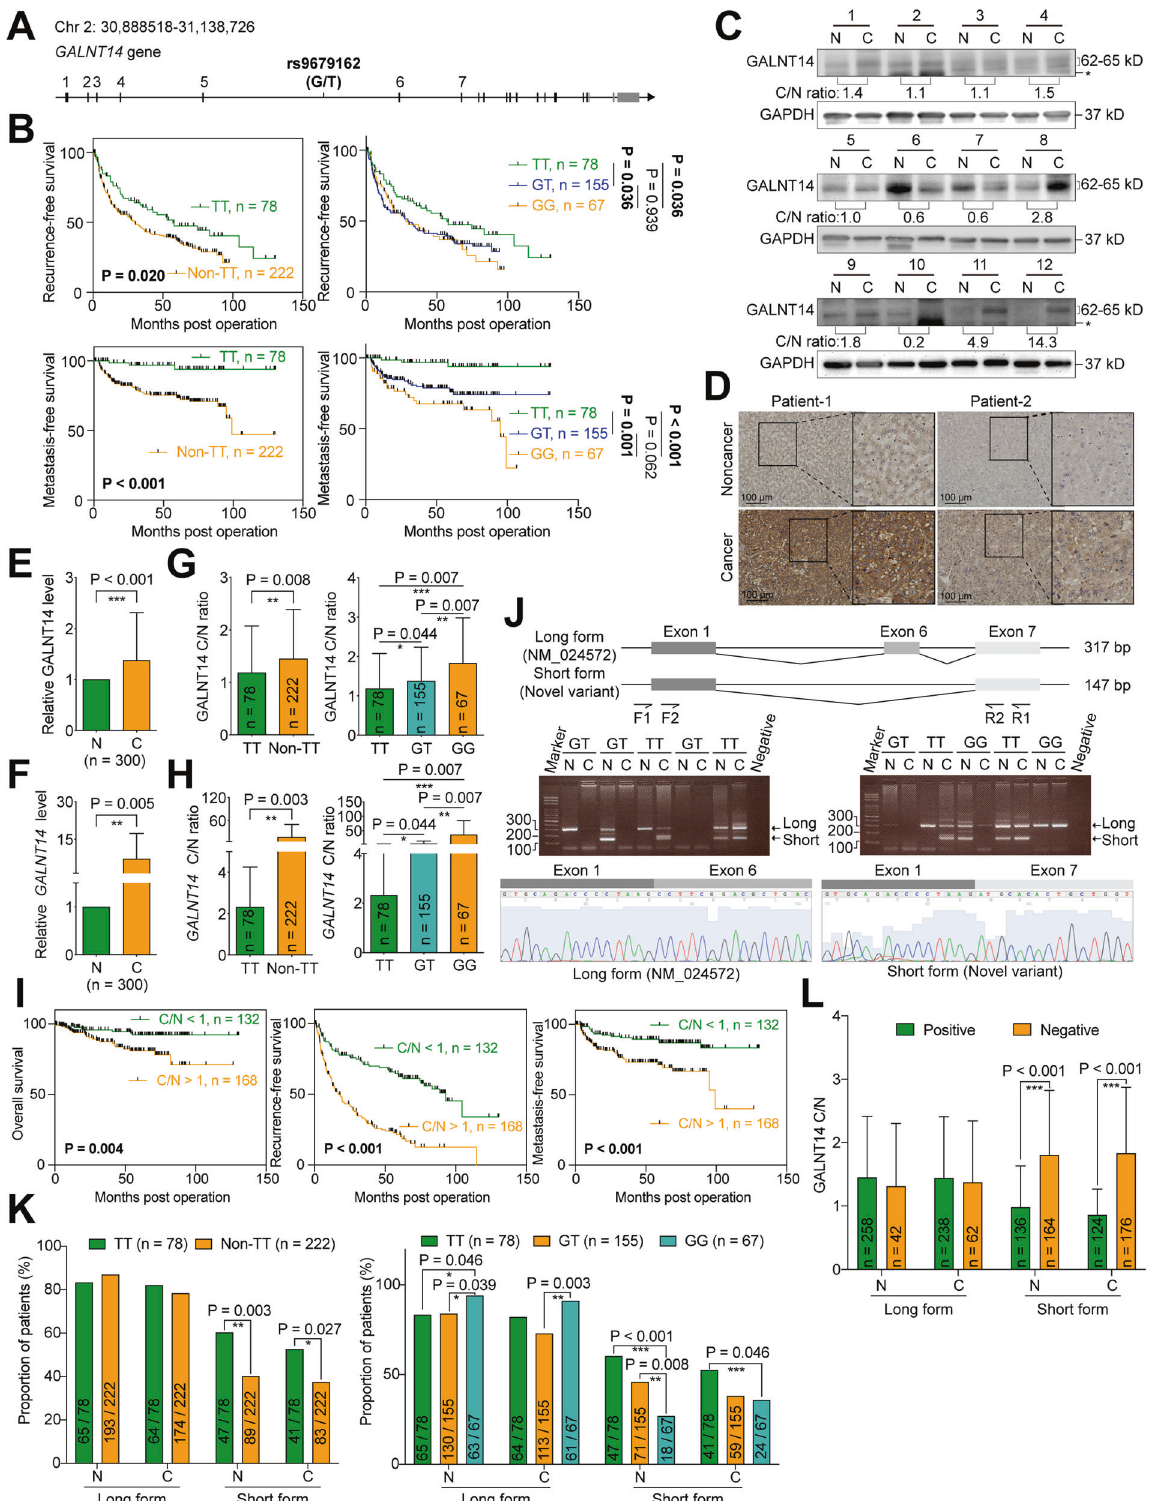
shown in Fig. 3D, PHB2 was enriched in Tn immunoprecipitates when GALNT14-overexpressing cell lysates were used (upper panels). Reciprocally, the Tn signal was observed only in immunoprecipitates of exo-PHB2 (with MYC tagged) from cell lysates co-expressing GALNT14 (lower